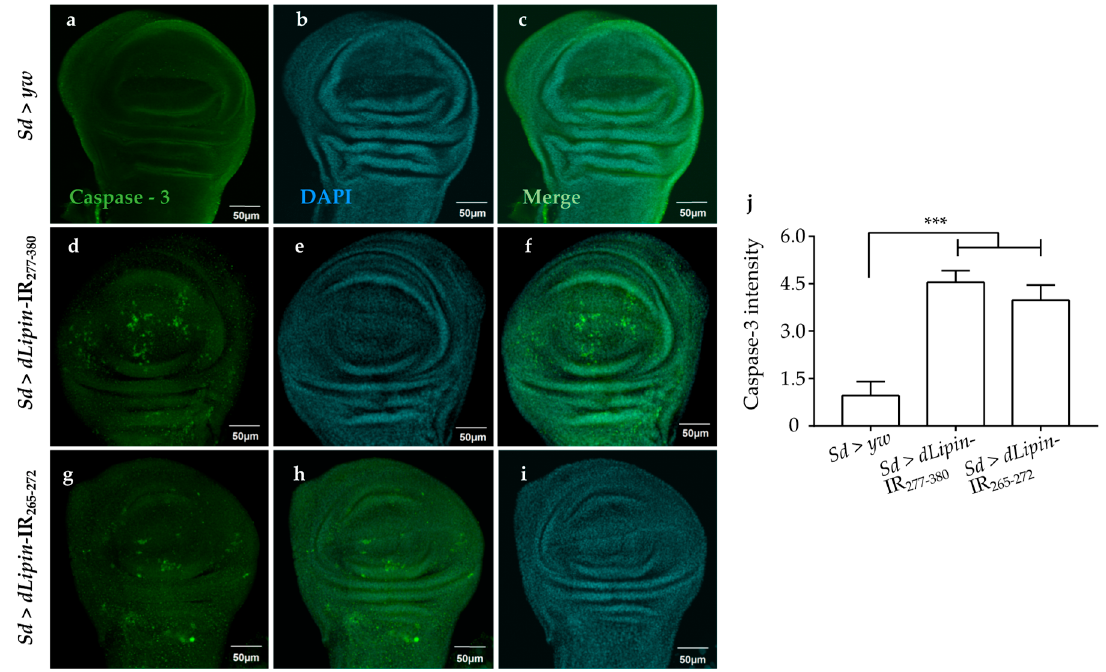
Figure 7. Knockdown of dLipin causes caspase-dependent cell death in wing imaginal discs of Drosophila. Wing imaginal discs from 3rd-instar larvae of control and dLipin- kd flies were stained with DAPI to visualize the DNA ( b, e, h ), and with rabbit anti-cleaved caspase-3 antibody followed by anti-rabbit IgG Alexa Fluor TM 488 antibody ( a, d, g ). Merged images of DAPI and anti-cleaved caspase-3 antibody are shown ( c, f, i ). The fluorescence intensity in the wing pouch stained with anti-cleaved caspase-3 antibody was analyzed using MetaMorph software ( n = 14 for each genotype) ( j ). Data are expressed as the means ± S.D. The statistical significance of the difference between control and dLipin -kd flies was evaluated using one-way ANOVA. ***, p < 0.01; Scale bar, 50 µm. IR, inverted repeat. Genotypes: Sd -GAL4/+; +; + ( a – c ), Sd -GAL4/+; UAS -dLipin- IR 277-380 /+; + ( d – f ), Sd -GAL4/+; UAS -dLipin- IR 254-476 /+; + ( g – i ).